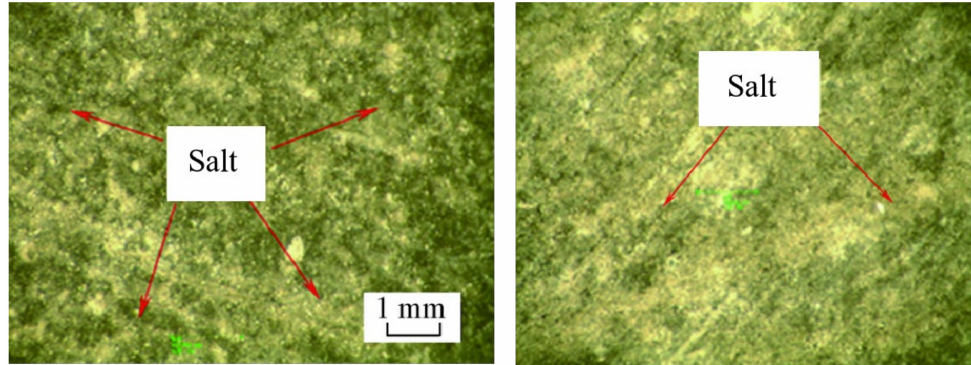
Figure 3. The scanning of shale bedding.